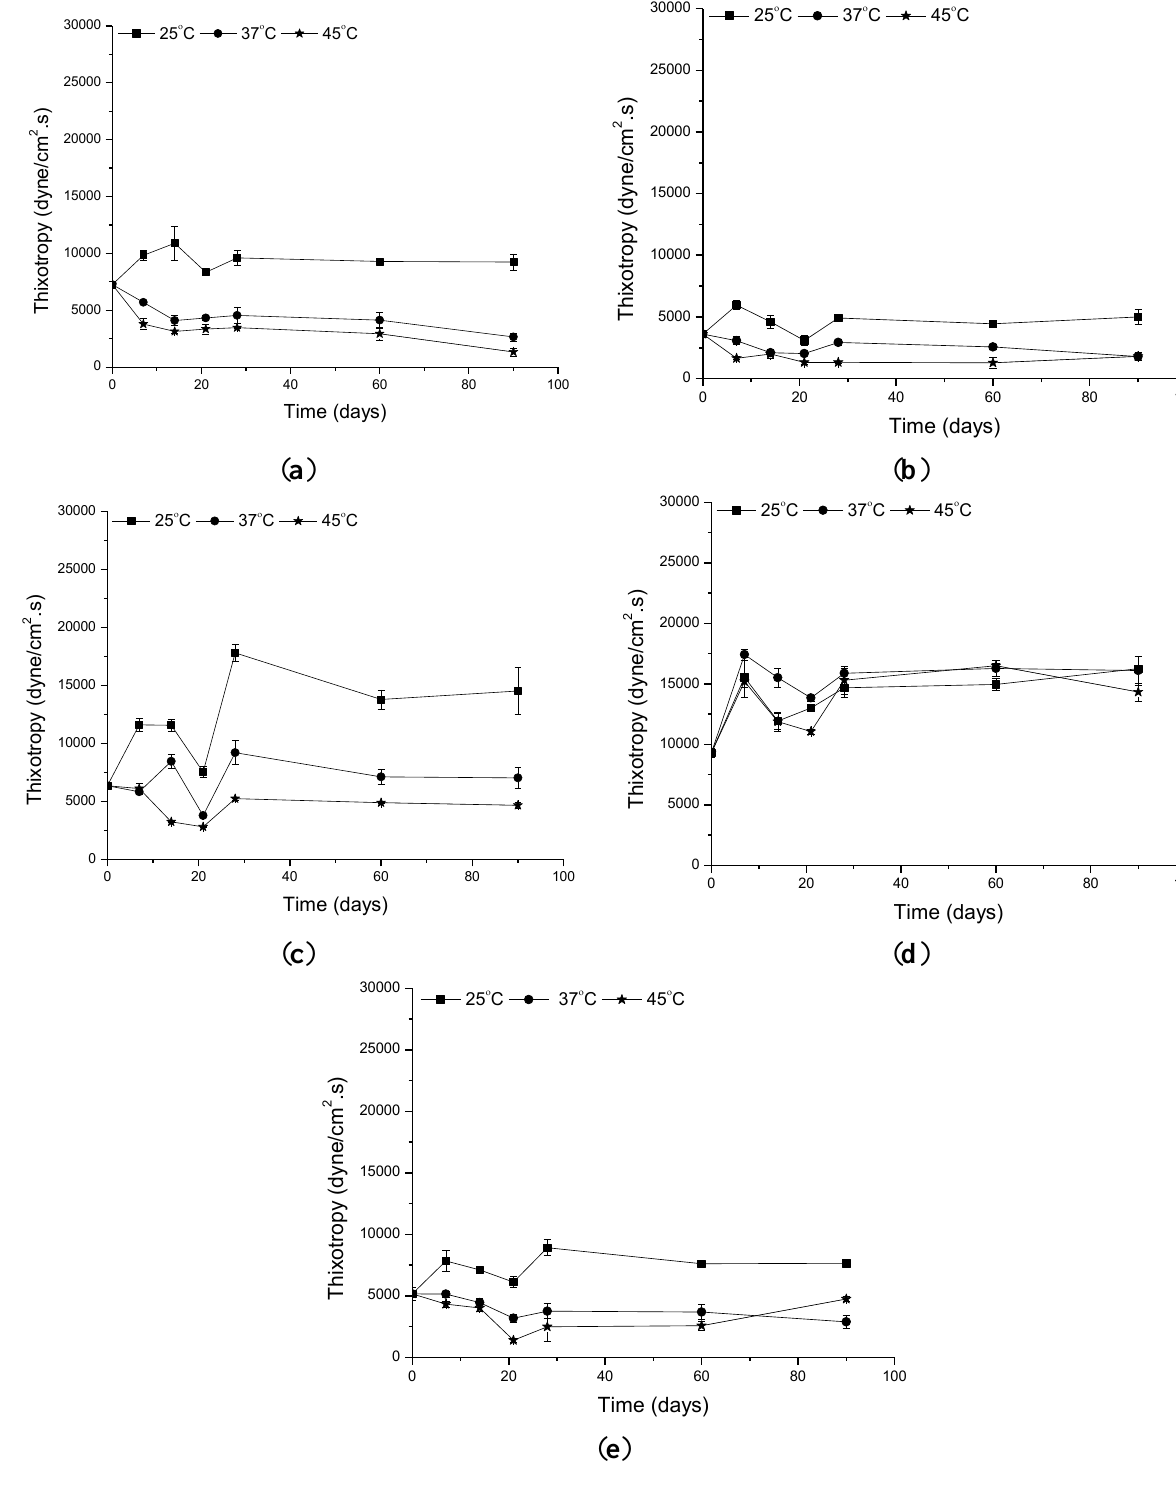
Figure 6. Changes in the thixotropy as a function of the time at different temperatures. ( a ) Formulation vehicle; ( b ) formulation containing the organic UV filters; ( c ) formulation supplemented with CePO ; ( d ) formulation supplemented with TiO 4 supplemented with